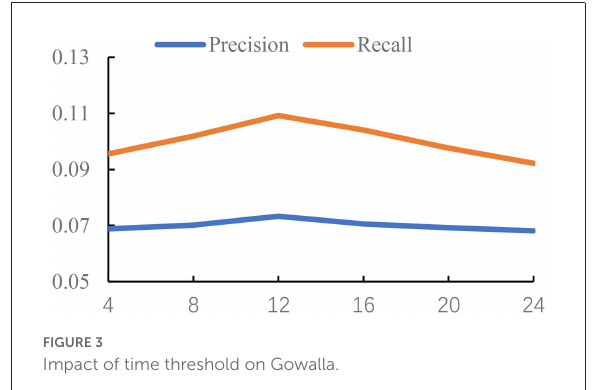
FIGURE3 Impact of time threshold on Gowalla.